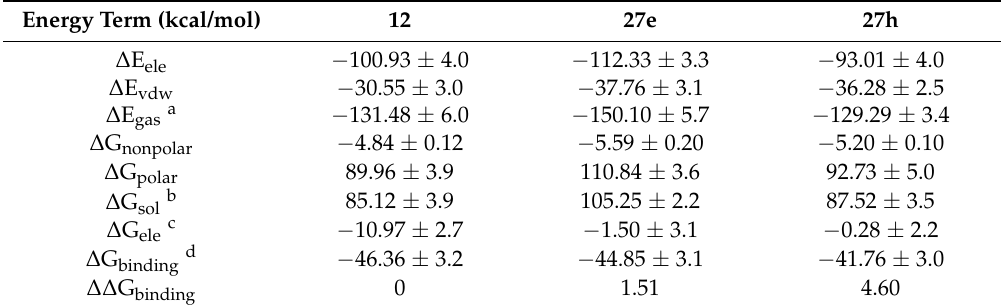
Table 1. Energy terms of MM/GBSA results for three CK2 α -inhibitor complexes systems. Energy Term (kcal/mol)